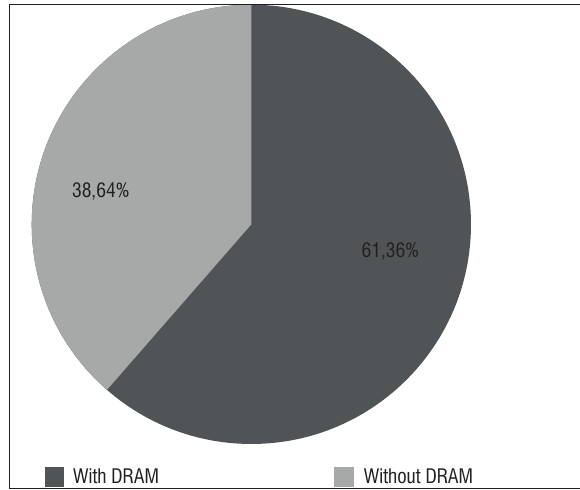
Figure 1 - Prevalence of women with DRAM in immediate puerpe- rium,